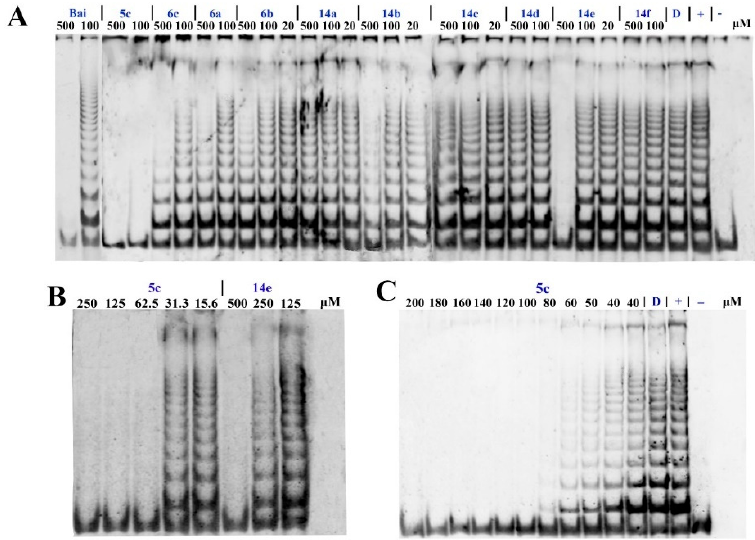
Figure 2. Inhibitory effects of the compounds against telomerase by TRAP-PCR assay. ( A ) The 10 compounds under different concentrations, baicalin as reference. ( B ) Compounds 5c and 14e under different concentrations. ( C ) Compound 5c under different concentrations. [D: DMSO (solvent control); +: contain cell lysate; -: no cell lysate] .